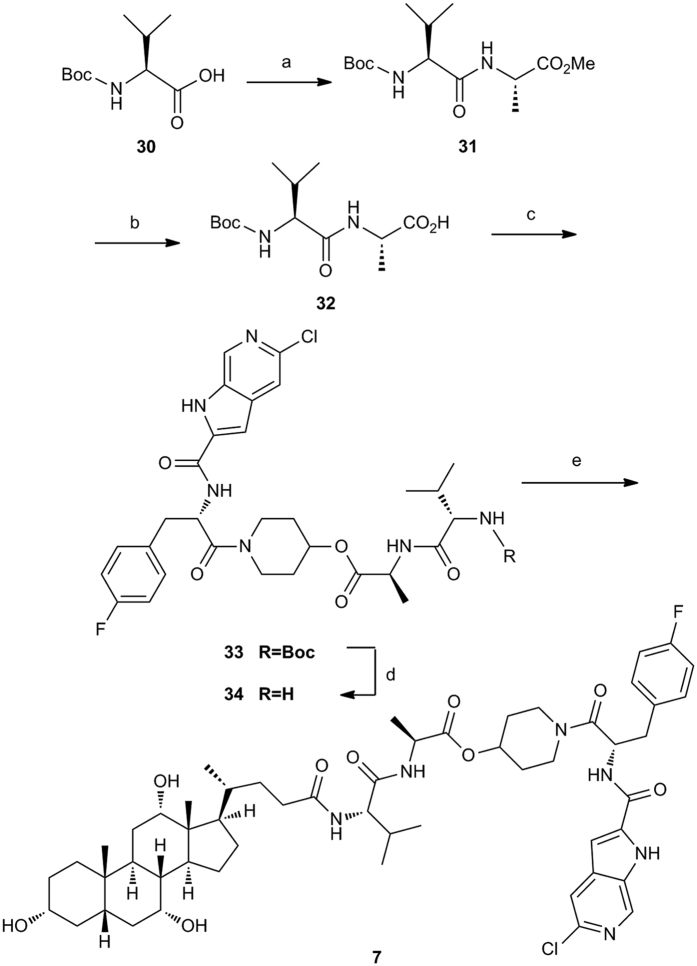
Synthesis of conjugate 7a.Reagents and conditions: (a) L-Alanine methyl ester hydrochloride, EDCI, HOBt, DIPEA, DMF, rt, 69.8%; (b) NaOH, MeOH/H2O, rt, 66.9%; (c) PSN-357, DCC, DMF, rt, 52%; (d) TFA, CH2Cl2, 0 °C; (e) Cholic acid, HATU, Et3N, DMF, rt, 2 steps 10.7% yield for 7.